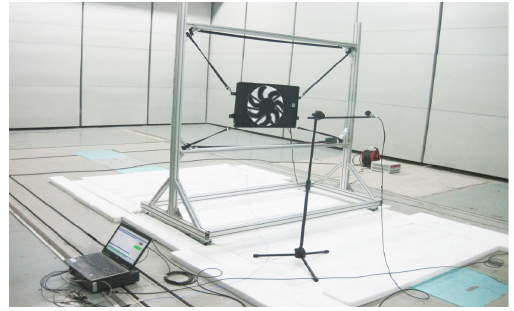
Figure 11. Test of single fan’s noise.